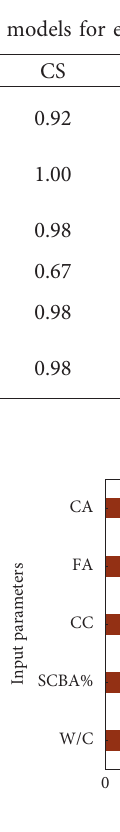
Figure 10: Importance of input variables on the targeted